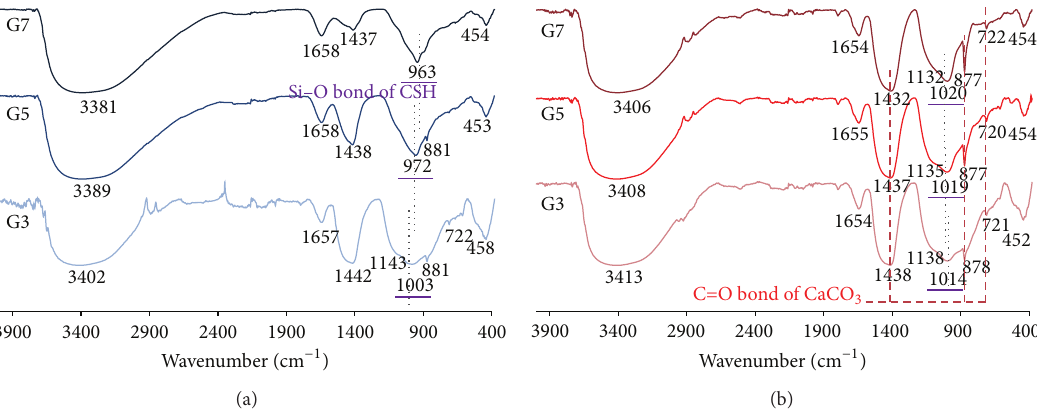
Figure 10: (a) Fourier-transform infrared spectra of noncarbonated AAS and (b) Fourier-transform infrared spectra of the carbonated AAS mortar.